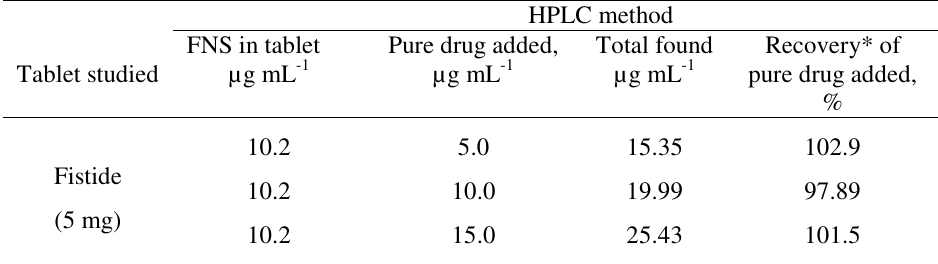
Table 4. Results of recovery